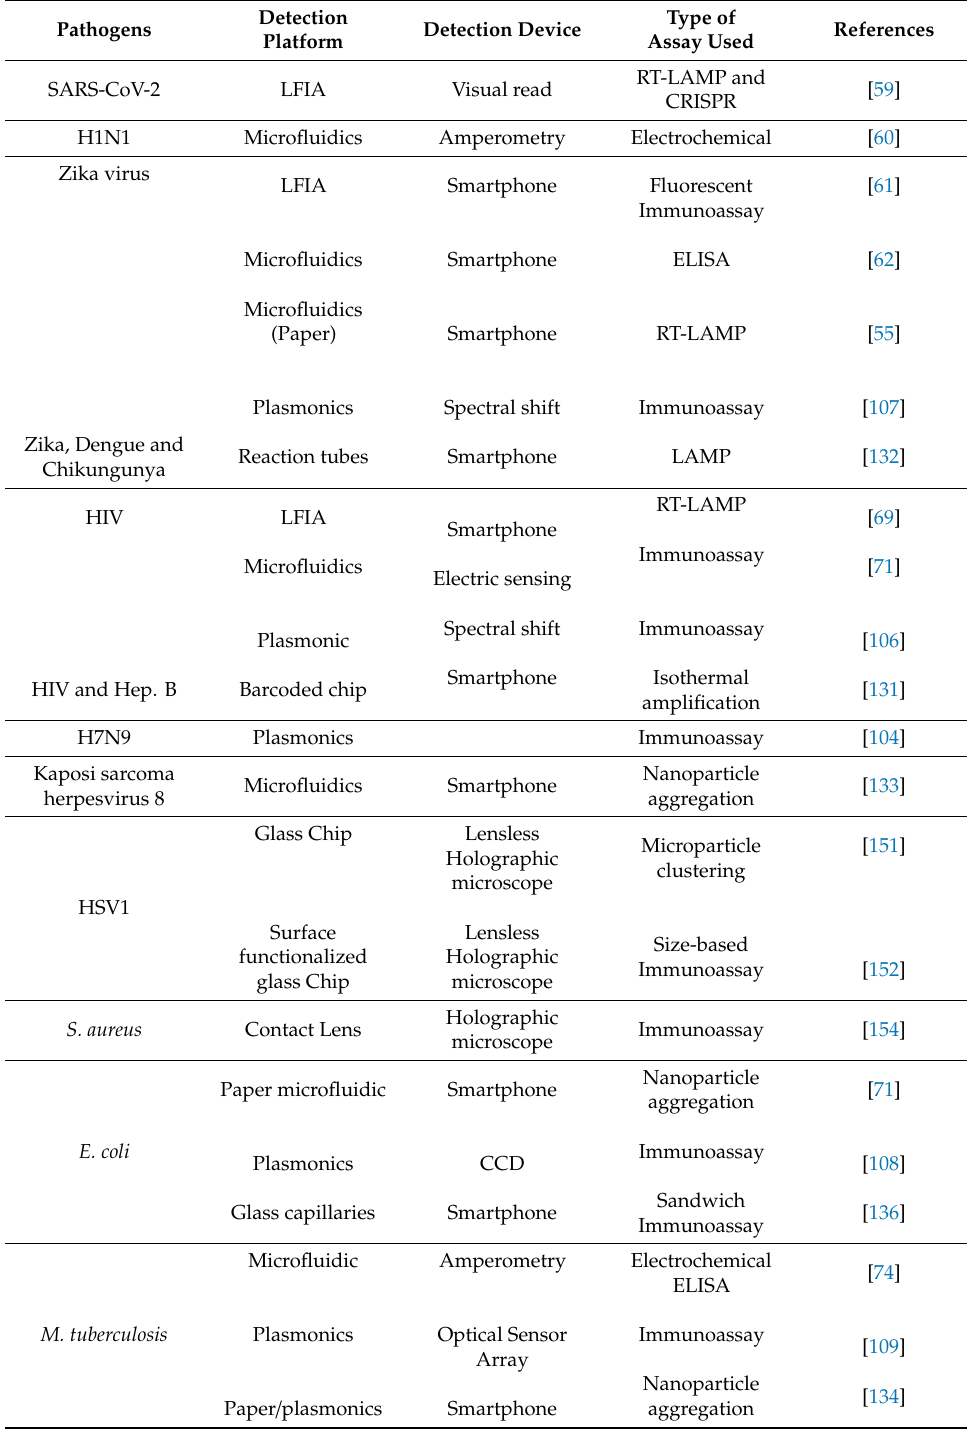
Table 1. A list of commonly used point-of-care (POC) technologies for the detection of some of the highly infectious bacterial and viral